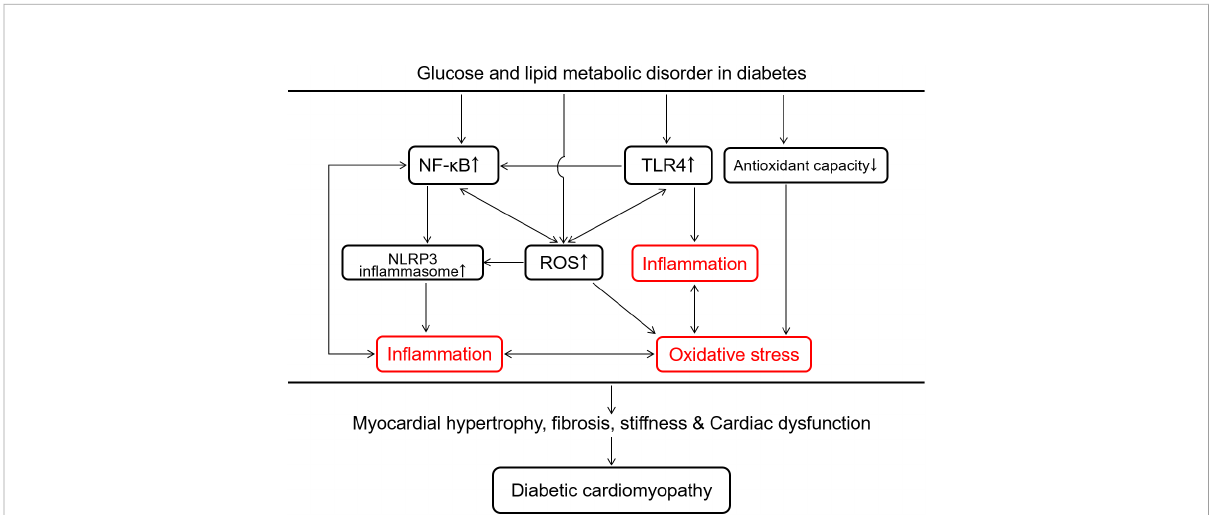
FIGURE 4 Overview of intracellular in fl ammation and oxidative stress interaction in response to glucose and lipid metabolic disorder in the development of diabetic cardiomyopathy. Glucose and lipid metabolic disorder in diabetes promotes cardiac in fl ammation via TLR4-mediated innate immunity, the surge of reactive oxygen species (ROS) and NF- k B-induced activation of NLRP3 in fl ammasome. The decrease in the antioxidant capacity and the increase in ROS production induced by the metabolic disorder both accelerate oxidative stress in the diabetic heart. In fl ammation and oxidative stress promote each other to cause myocardial hypertrophy, fi brosis, stiffness and cardiac dysfunction, which is a potentially vicious cycle in the development of diabetic cardiomyopathy. NF- k B, nuclear factor k -light-chain-enhancer of activated B cells; NLRP3, nucleotide- binding domain, leucine-rich-containing family, pyrin domain containing 3; TLR4, toll-like receptor